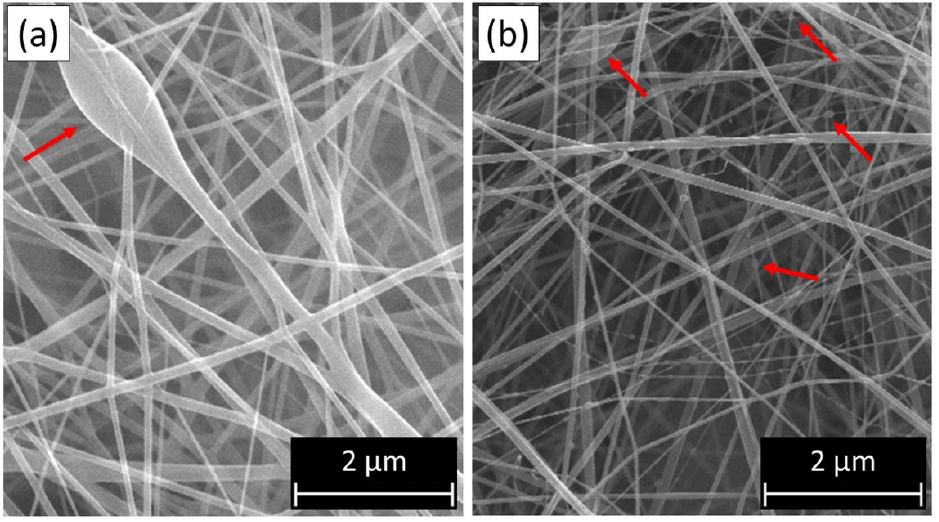
Figure 2. Formation of beads on electrospun fibers: ( a ) large beads; ( b ) small beads. One of the determining parameters in electrospinning is viscosity. It is directly related to the concentration of the solution and the molar mass of the polymer used. At low polymer concentrations (low viscosity values), the electrospun jet breaks up on its way to the collector, due to surface tension. Thus, no fibers are formed. In this case, the formation of polymer droplets (electrospraying) or fibers with beads occurs due to viscoelastic forces that would not dampen the breakage mechanism. As the concentration of the polymeric solution increases (higher viscosity values), the probability of fiber formation increases, as the viscoelastic forces are more pronounced. However, the diameter of the electrospun fibers also increases with increasing solution viscosity. Another disadvantage of using very viscous solutions is that they can cause the needle to clog during the electrospinning process